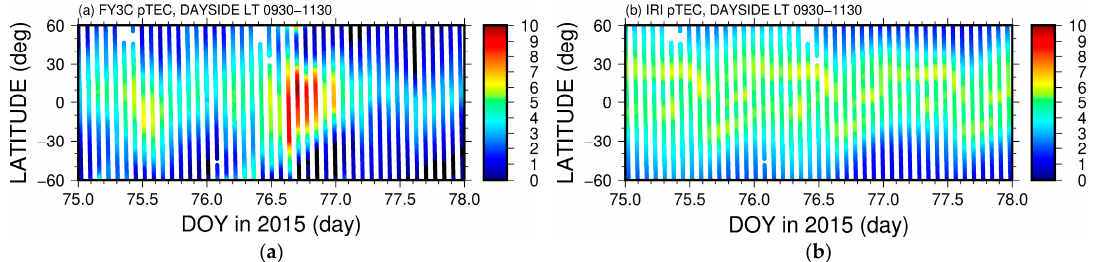
Figure 10. pTEC variations (unit: TECU) along FY3C orbit during DOY 075-077/2015 with respect to latitude and universal time: ( a ) The FY3C pTEC estimations; and ( b ) the IRI 2016 pTEC predictions. The latitude regions are conformed from –60° S to 60° N while only the dayside tracks (mainly during LT 0930–1130) are shown for better visualization. Responses to the geomagnetic storm is represented by the FY3C-based pTEC estimates as strong pTEC increment during storm main phase and TEC depletion during storm recovery phase.